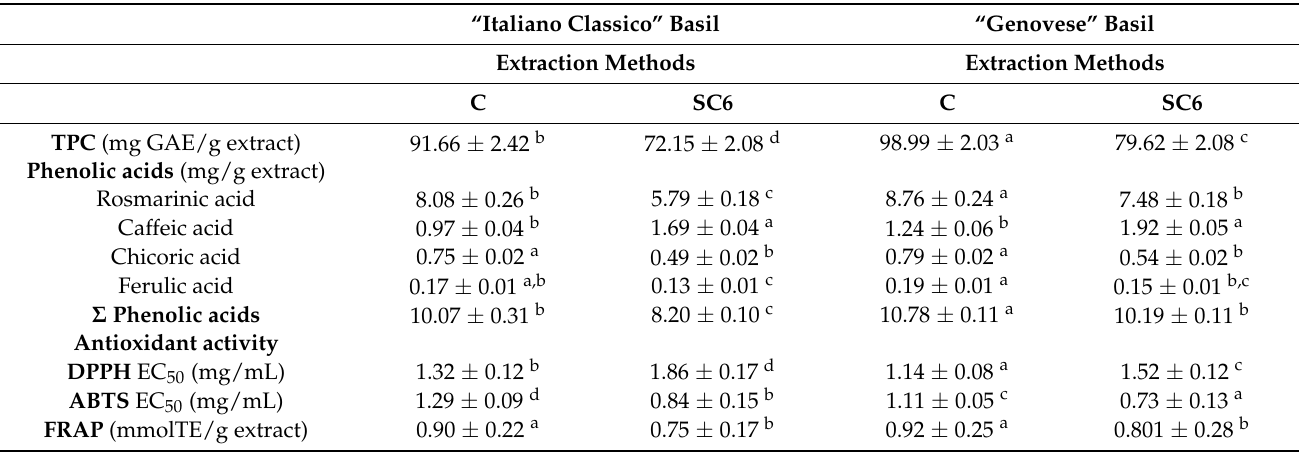
Table 2. Total phenol content (TPC), phenolic acids, and antioxidant activity determined by DPPH, ABTS, and FRAP assays in “Italiano Classico” and “Genovese” basil extracts obtained by different methods (C: ethanol; SC6: supercritical CO 2 + 10% ethanol).